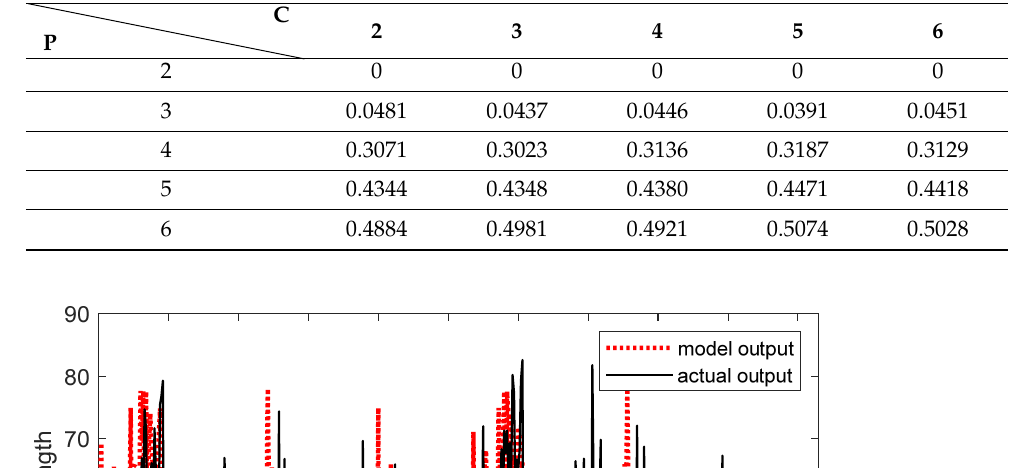
Table 4. Prediction performance CGK-based fuzzy granular model of the aggregated structure that generated contexts flexibly.